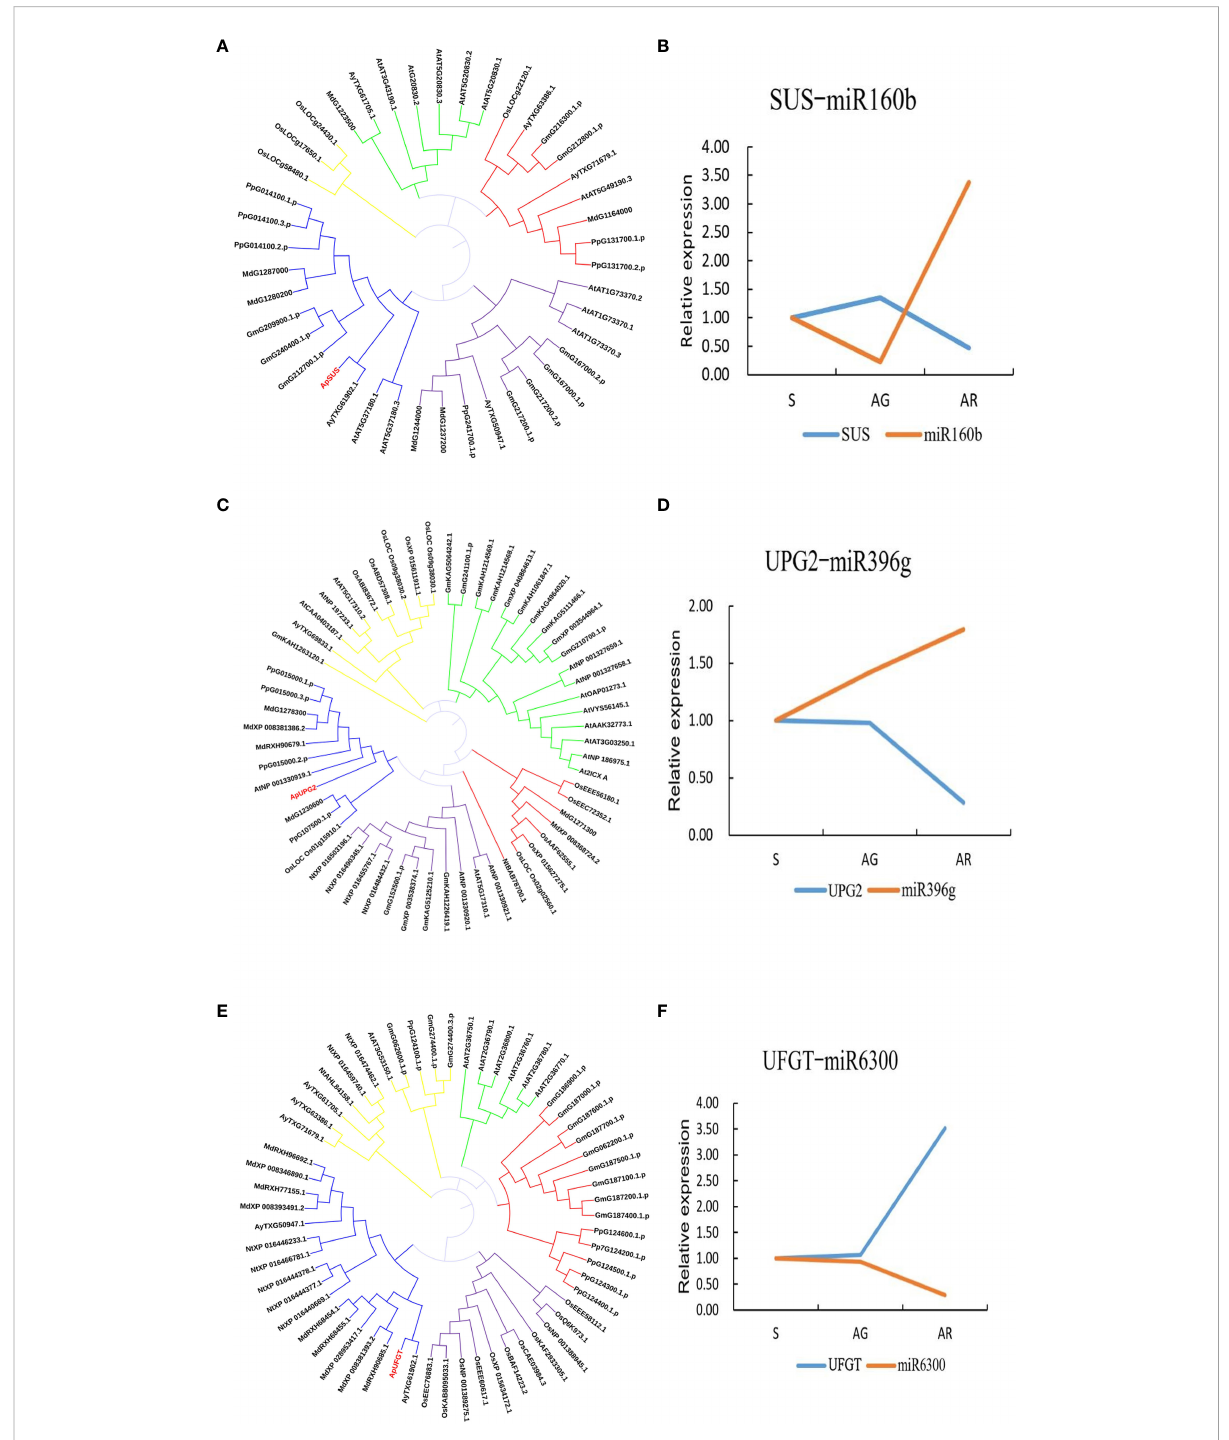
FIGURE 8 Phylogenetic tree of three key genes and fl uorescence quantitative veri fi cation results of their corresponding miRNA. (A) Phylogenetic tree of SUS. (B) Relative expression of ApSUS -mi160b during leaf color transition. (C) Phylogenetic tree of UGP2. (D) Relative expression of ApUPG2 - miR396g during leaf color transition. (E) Phylogenetic Tree of UFGT. (F) Relative expression of ApUFGT -miR6300during leaf color